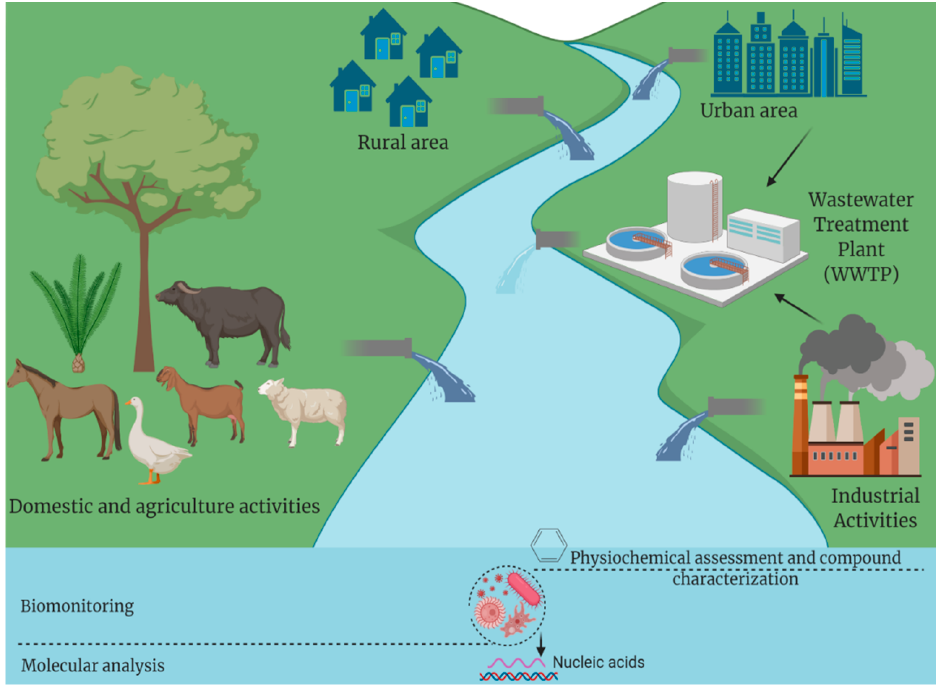
Figure 1. Sources of anthropogenic pollutants and current approaches for aquatic biomonitoring. The figure is assembled using dynamic BioRender assets.